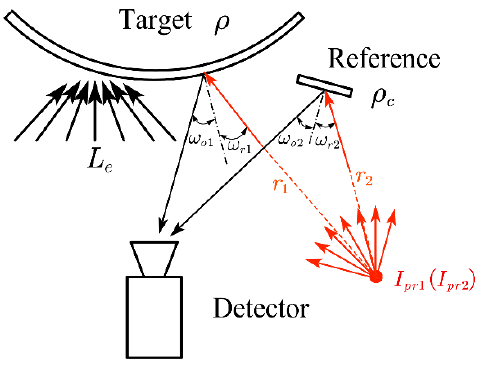
(24) 2.3.2. Applying a Point Source Irradiation When a point source with a radiant intensity of 1 pr I as shown in Figure 7 is applied,